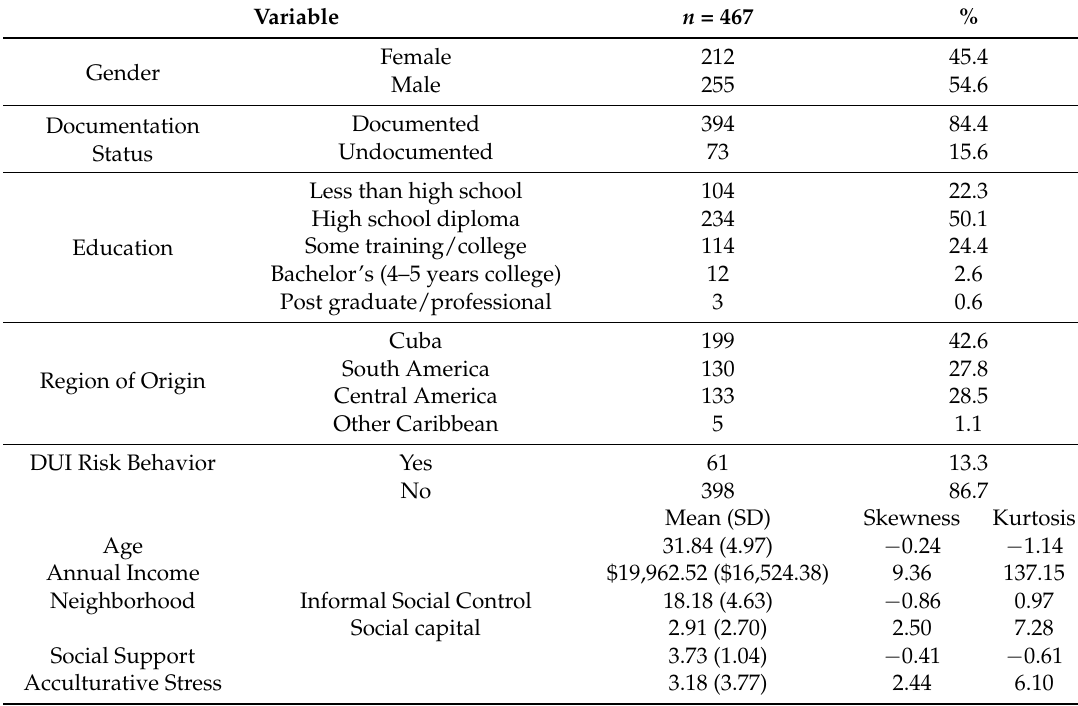
Table 1. Sample demographics ( n = 467).